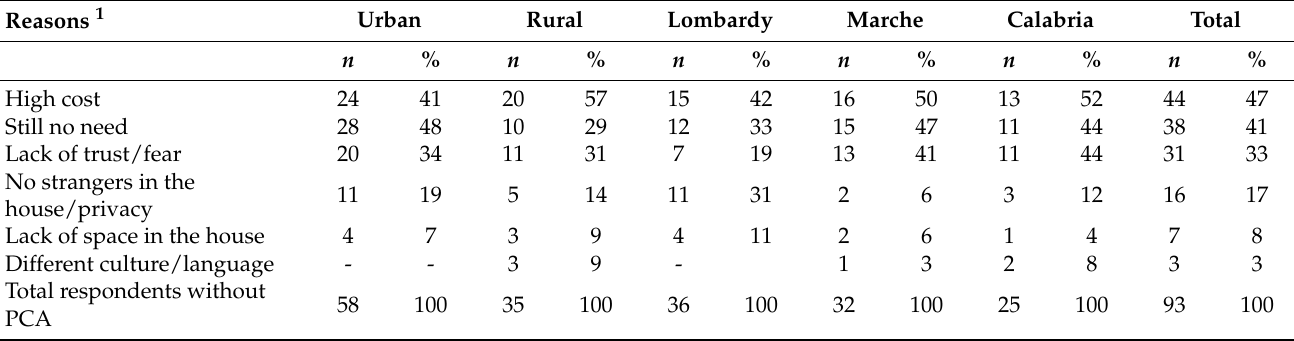
Table 3. PCA absence and reasons, by sites and